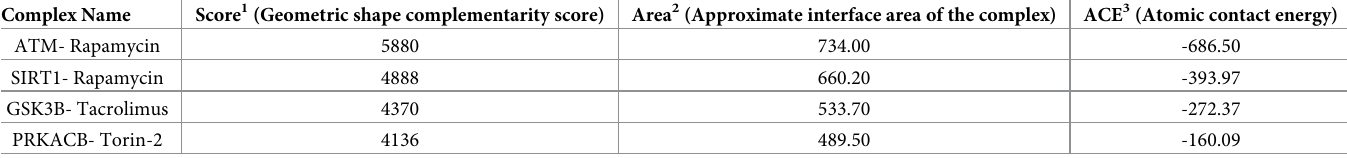
tify different disease severity and prognosis of COVID-19 patients [103]. The leukocyte differ- entiation may strongly control the SARS-CoV-2 since it is interconnected with respiratory Table 3. PatchDock docking results corresponding to the most significant complexes between drugs and